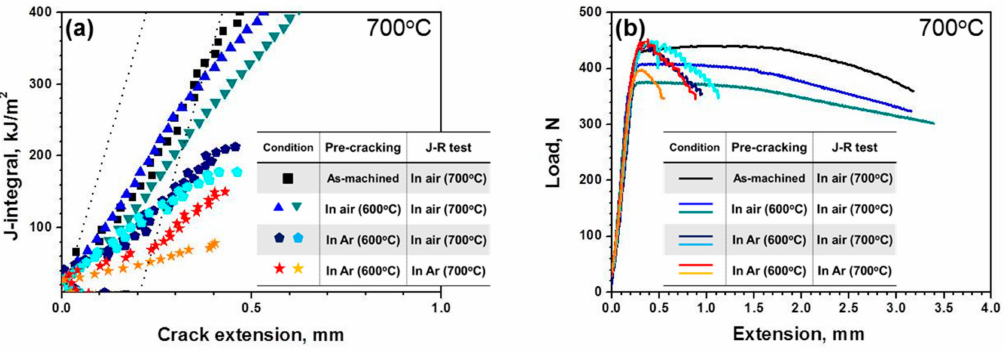
Figure 6. The results of fracture toughness test at 700 ◦ C; ( a ) the load-extension curves, ( b ) the J-integral-crack extension